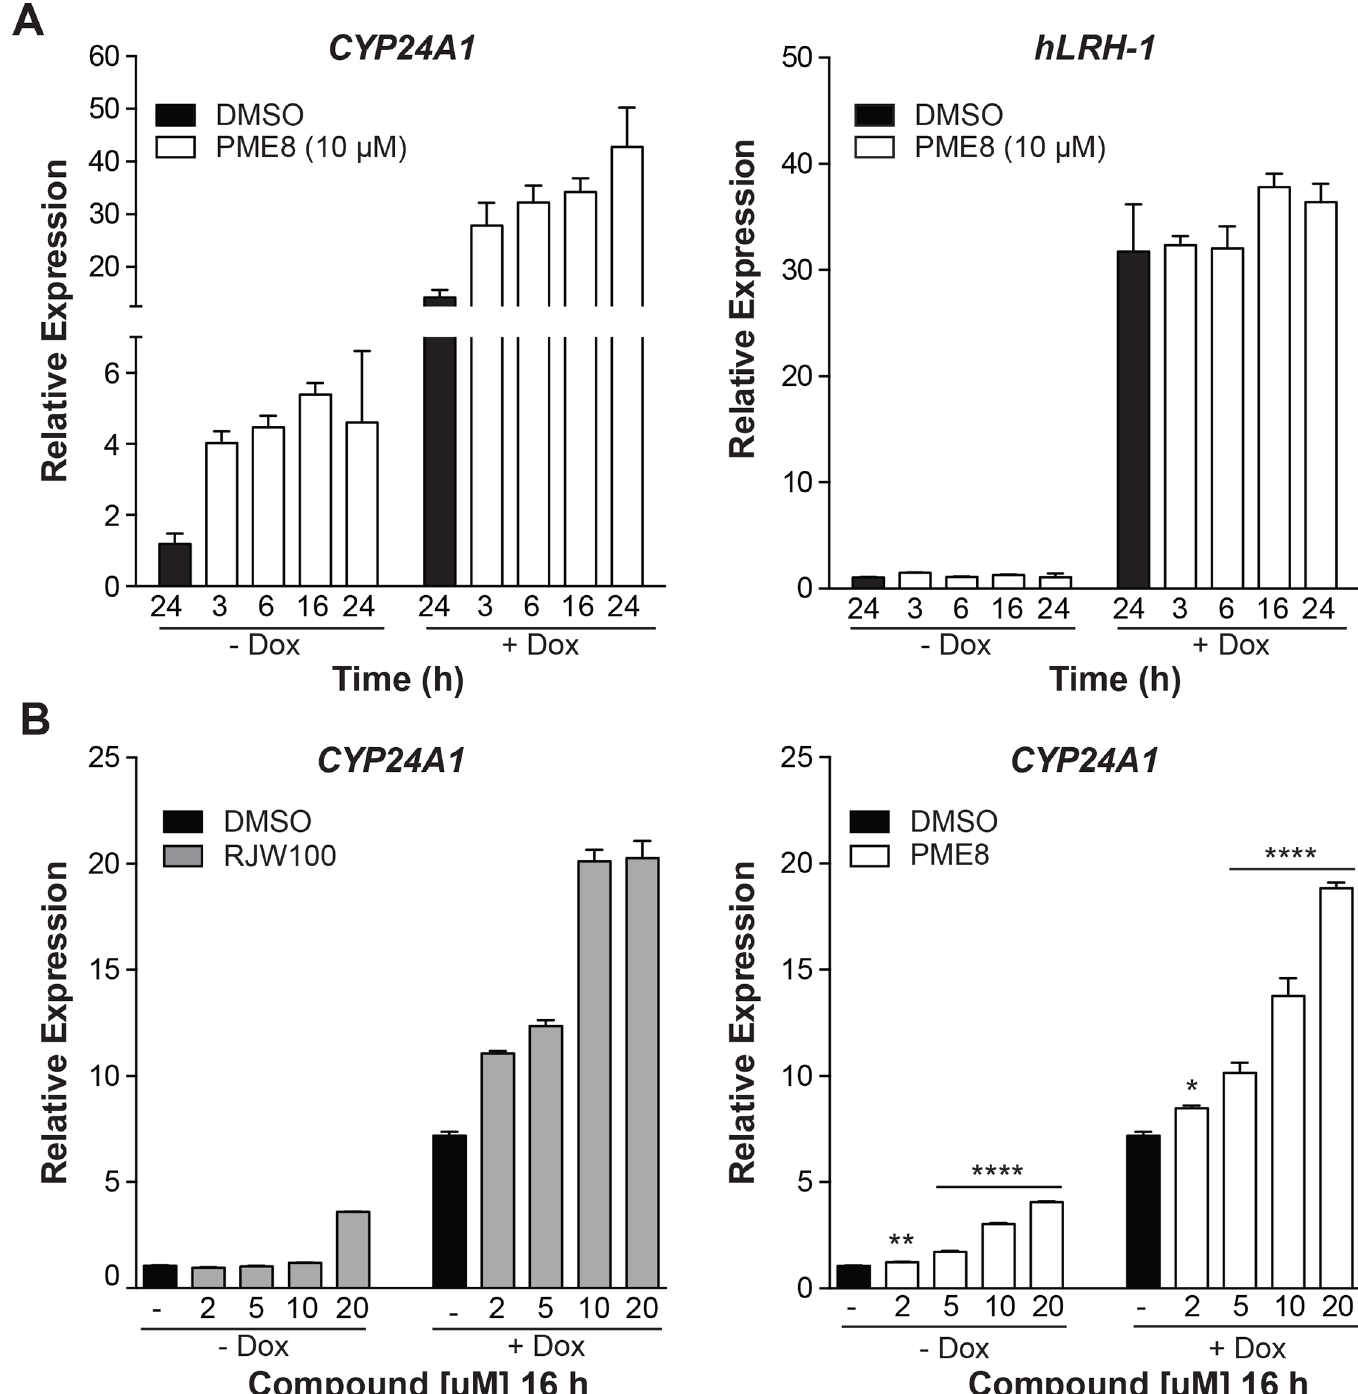
Fig 3. PME8 induces transcription of an hLRH-1 target gene in a both time- and dose-dependent manner with activity increasing at higher hLRH-1 levels. A. Relative expression levels of the hLRH-1 target gene CYP24A1 with increasing treatment times of PME8 (10 μ M) compared to the DMSO control (black bar) ranging from 3 – 24 h. Corresponding expression levels of hLRH-1 transcripts in each time condition are shown in right panel without (-Dox) or with (+Dox) induction of exogenous hLRH-1. B. Levels of CYP24A1 with DMSO or with increasing concentrations of RJW100 and PME8 treatment for 16 h without (-Dox) or with (+Dox) induction of exogenous hLRH-1. Data are representative of at least three independent experiments with error bars representing SEM, P values = **** < 0.0001.